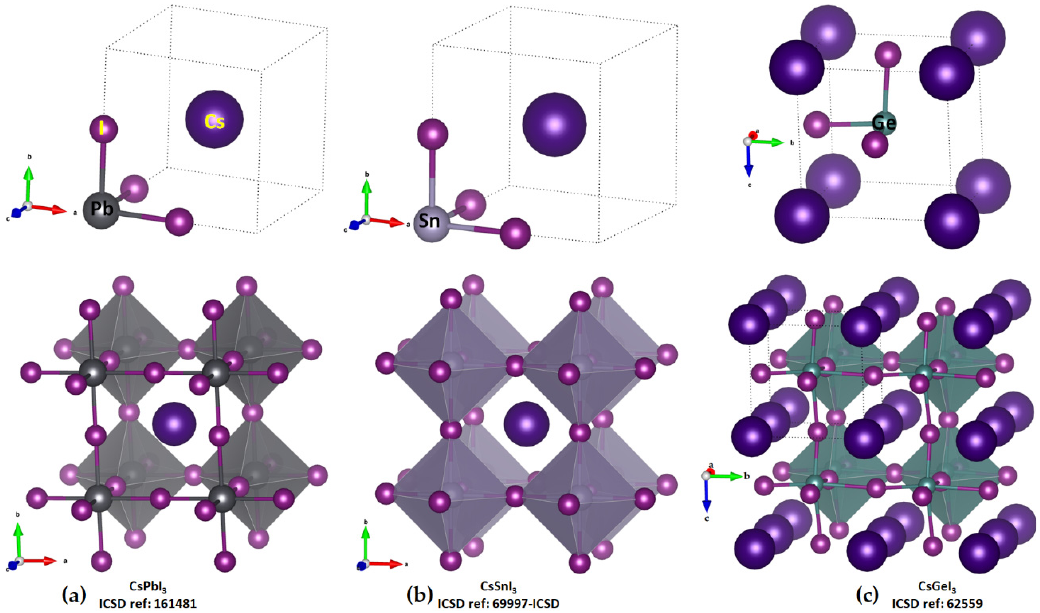
Figure 2. Top: the ball-and-stick models of the unit cells of cesium tetrel iodide perovskites. ( a ) CsPbI 3 ; ( b ) CsSnI 3 ; ( c ) CsGeI 3 . Bottom: illustration of the polyhedral and ball-and-stick models of corner-shared octahedra for these systems, forming cage-like structures. The ICSD reference is shown in ( a – c ).